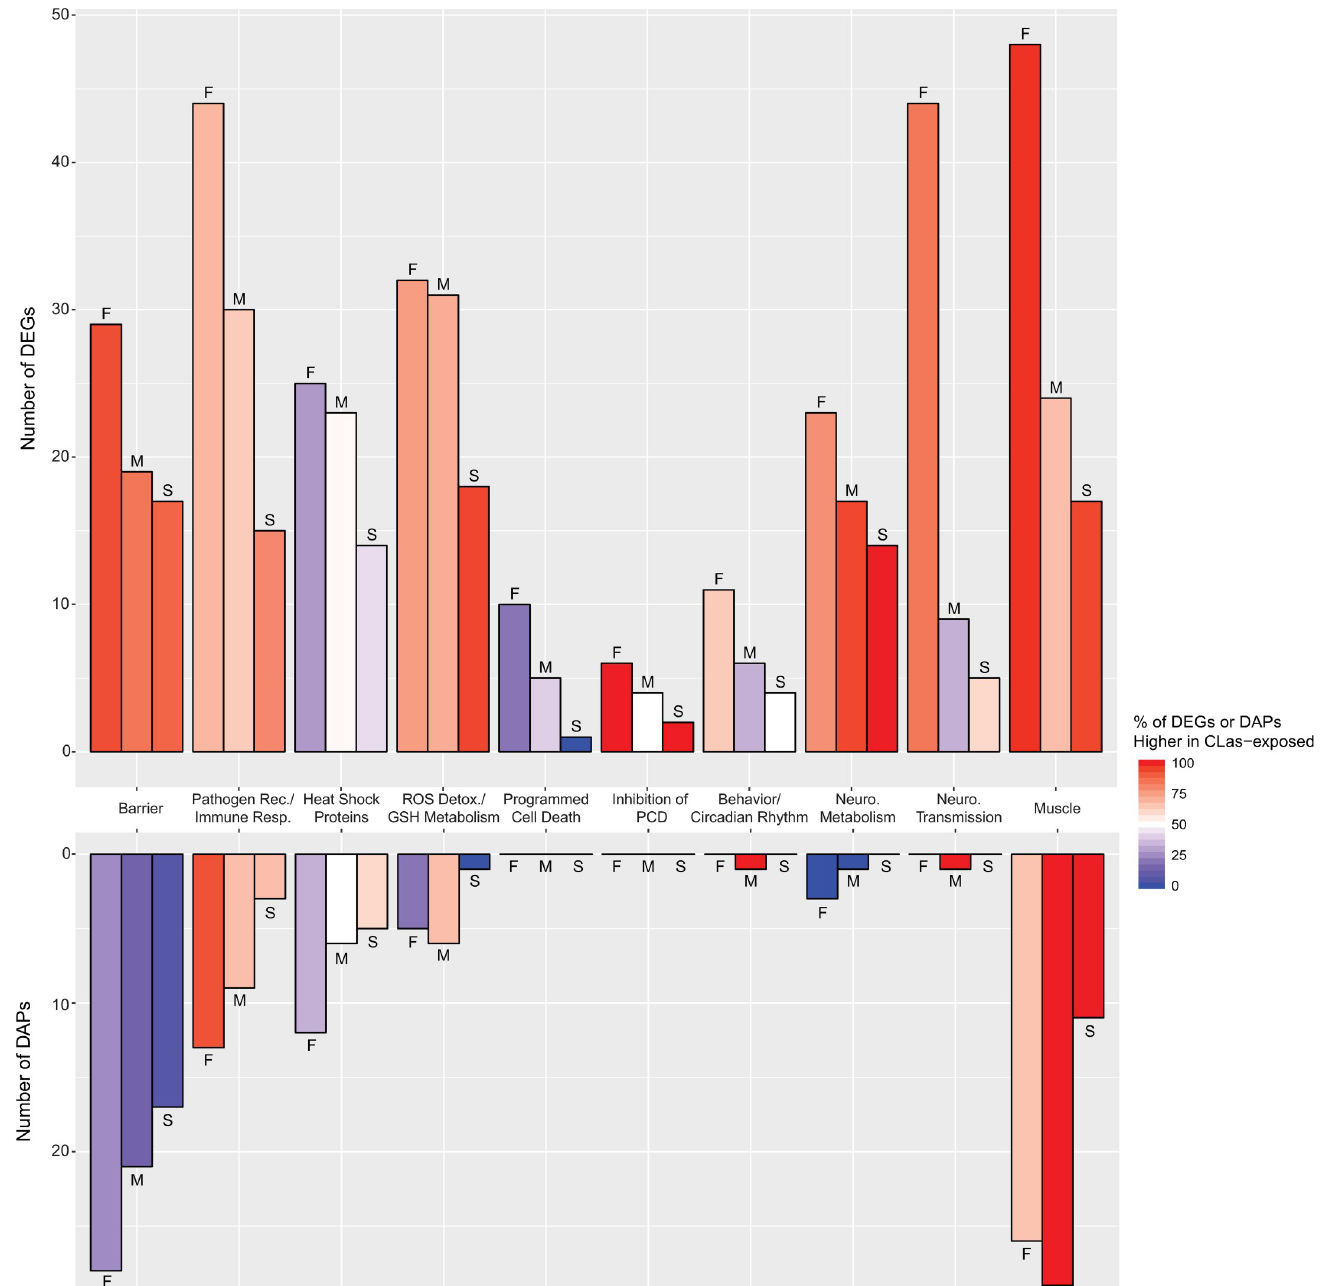
Fig 8. Number of DEGs and DAPs, and percentage that are more expressed/abundant with CLas exposure, by predicted function. The number of DEGs or DAPs for a particular functional category from females (bars marked with “F”), for males (bars marked with “M”), and shared between sexes (bars marked with “S”) in response to CLas exposure are depicted by the bar height. The percentage of DEGs or DAPs in that functional category that are up-regulated with CLas exposure for that group (females, males, or shared) is depicted by the color of the